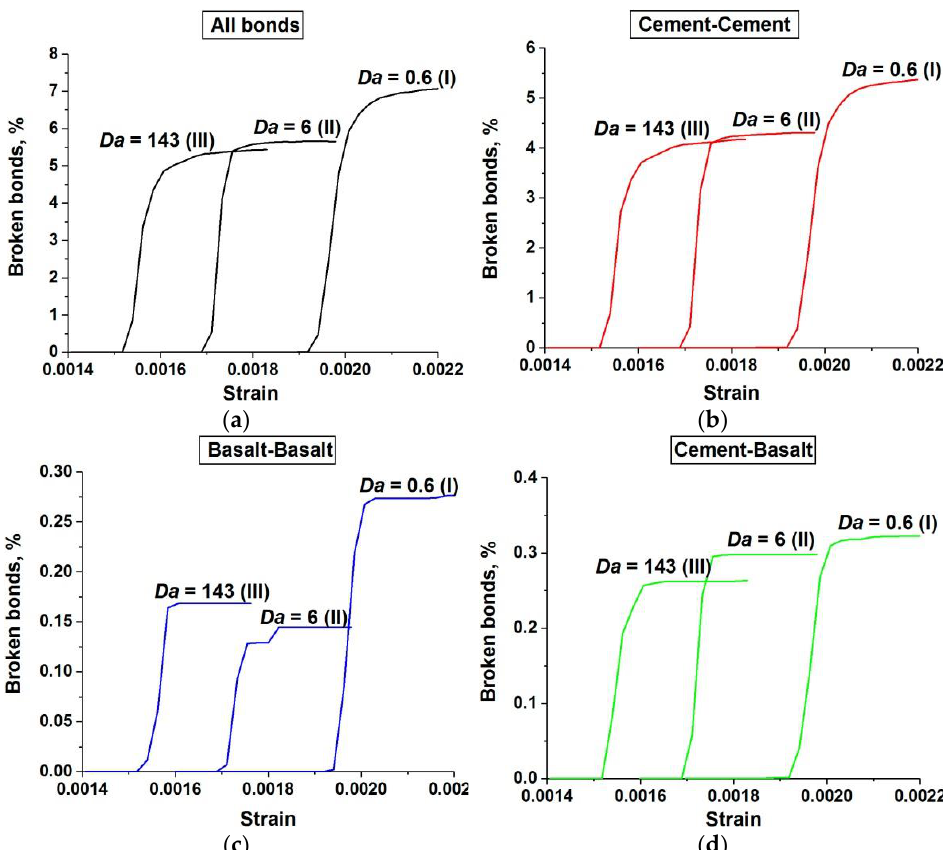
Figure 12. The dependences of the number of broken bonds in the fluid-saturated concrete sample with two-scale pore structure (capillary porosity and 4 vol.% micropores) on the value of applied strain: ( a ) all broken bonds; ( b ) broken bonds in cement stone; ( c ) broken bonds in basalt aggregates; ( d ) broken bonds at the interphase boundaries. The number of broken bonds is normalized by the total number of bonds in the unstrained sample. Roman numerals I, II, and III denote the number of the corresponding section of the unified curve σ comp ( Da ).